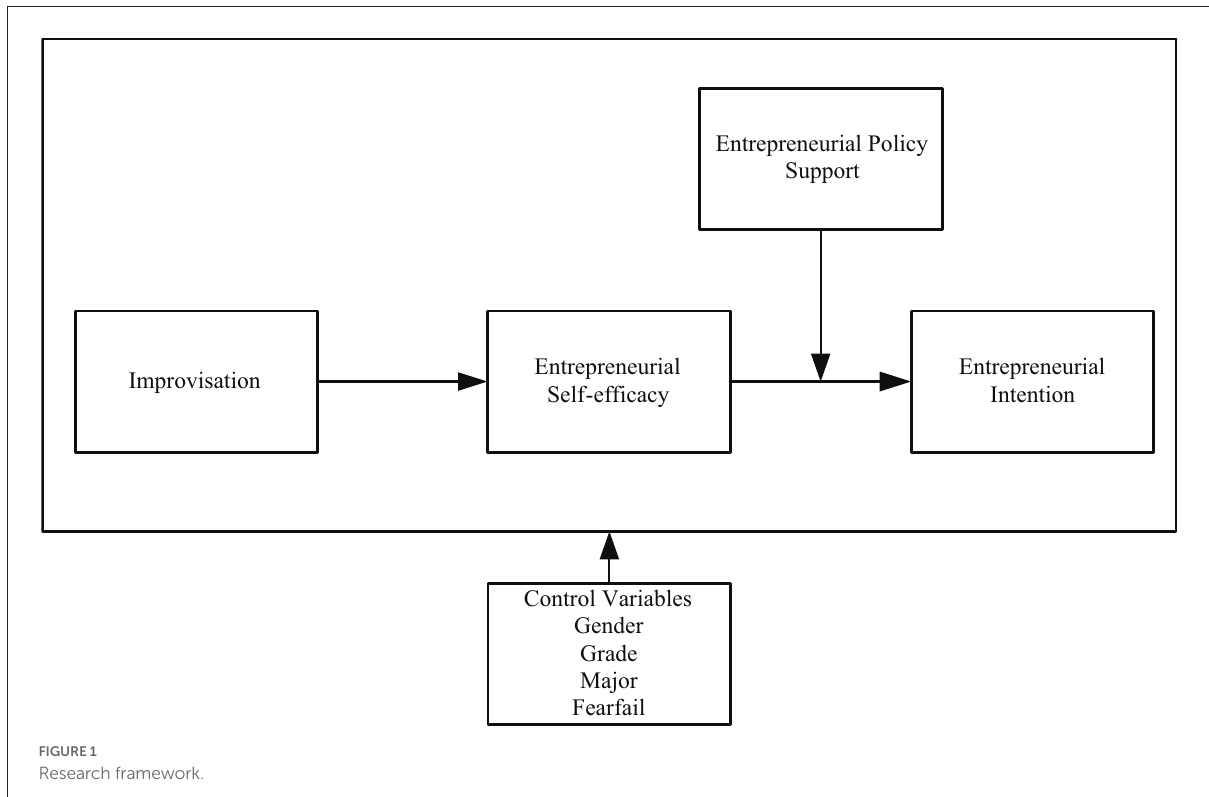
FIGURE 1 Research